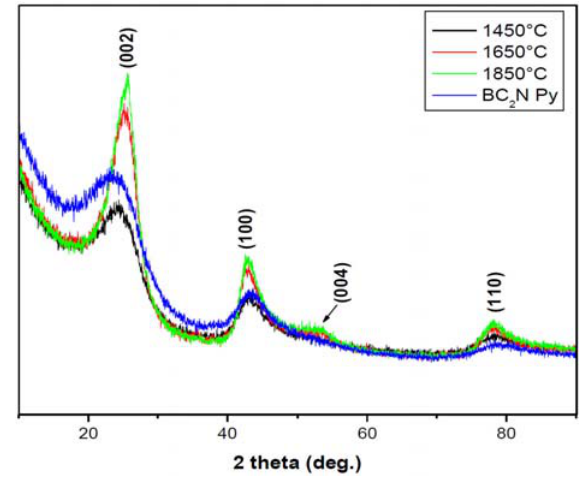
Figure 1. X-ray diffraction patterns of the BN-C materials heat treated at different temperatures, BN-C Py refers to the material pyrolysed at 1,050 °C (Y-scale is the intensity in